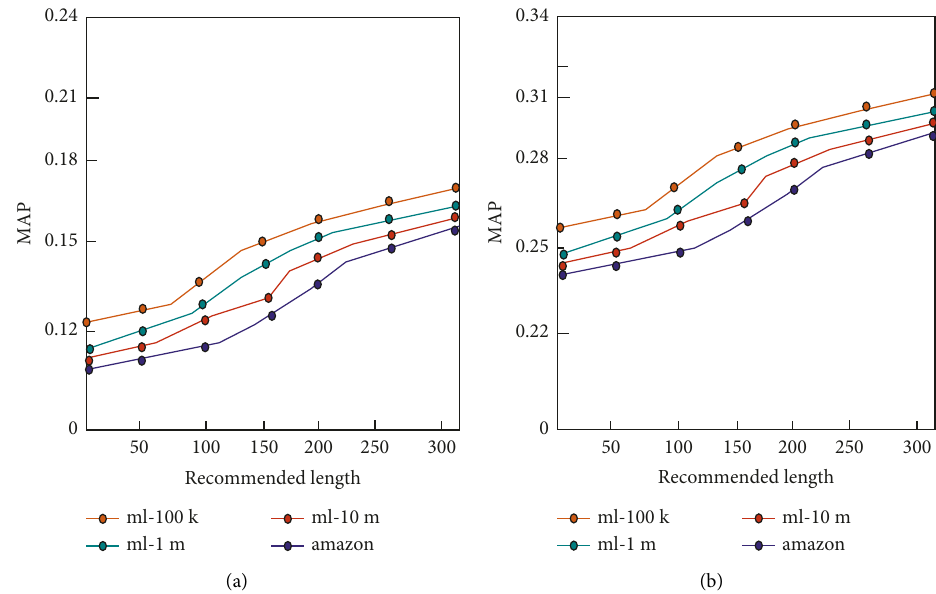
Figure 6: Map of the recommendation model before improvement and a single recommendation algorithm on different datasets. (a) Map of a single recommendation algorithm. (b) Map of recommendation model based on deep neural network.